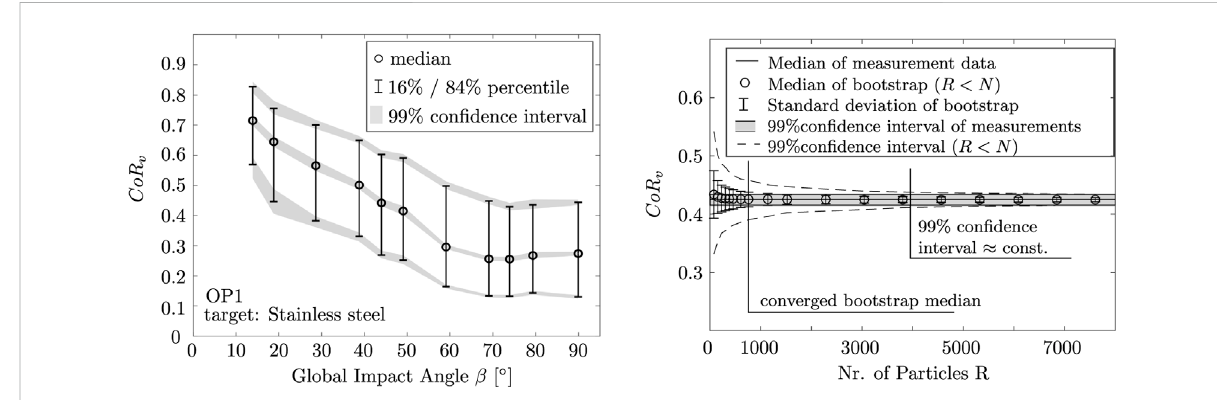
FIGURE 6 Measurementuncertainty: (A) 99%con fi dence intervals for thedistribution ’ smedian CoR v anditspercentileover theimpactangle; (B) usage of the bootstrapping technique to check for a signi fi cant sample size (Ti6Al4V, OP1, 50 ° ).